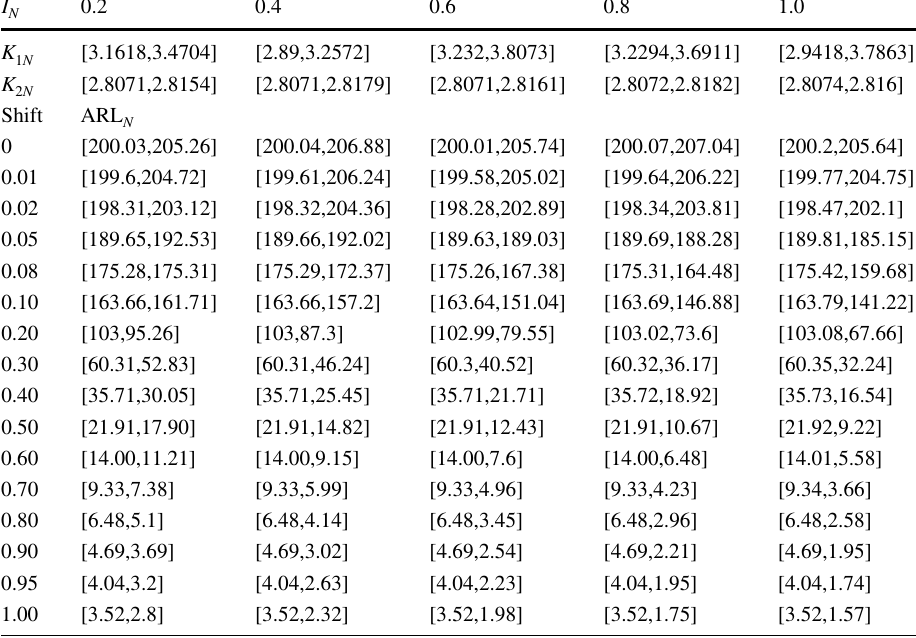
Table 1 The average run length ARL 1 values under neutrosophic statistics for n L =